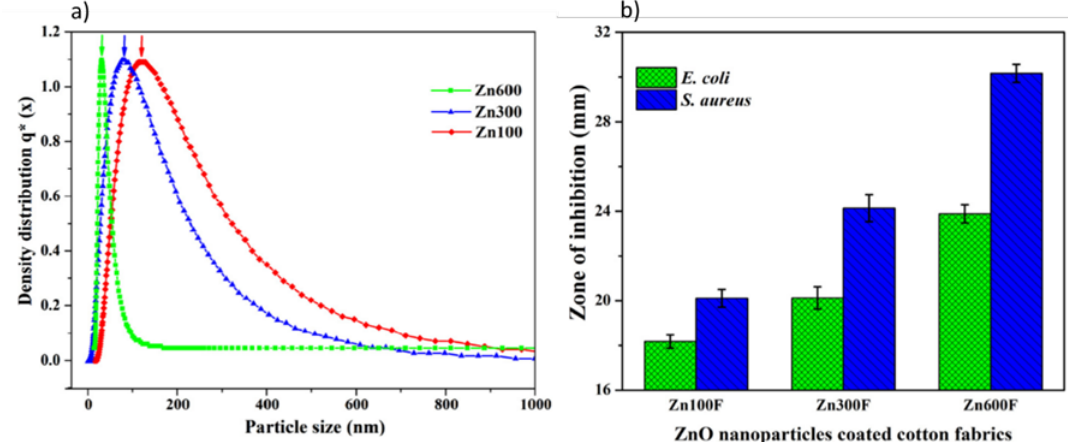
Figure 5. Particle size distribution curves of ZnO NPs ( a ), antimicrobial activity of ZnO NPs coated cotton fabric ( b ). Sample codes: Zn600, Zn300 and Zn100 are ZnO nanopowders calcined at 100, 300 and 600 °C, respectively; Zn100F, Zn300F and Zn600F are fabric samples coated with different ZnO nanopowders. Reprinted with permission from [11]. Copyrights 2017 Elsevier.